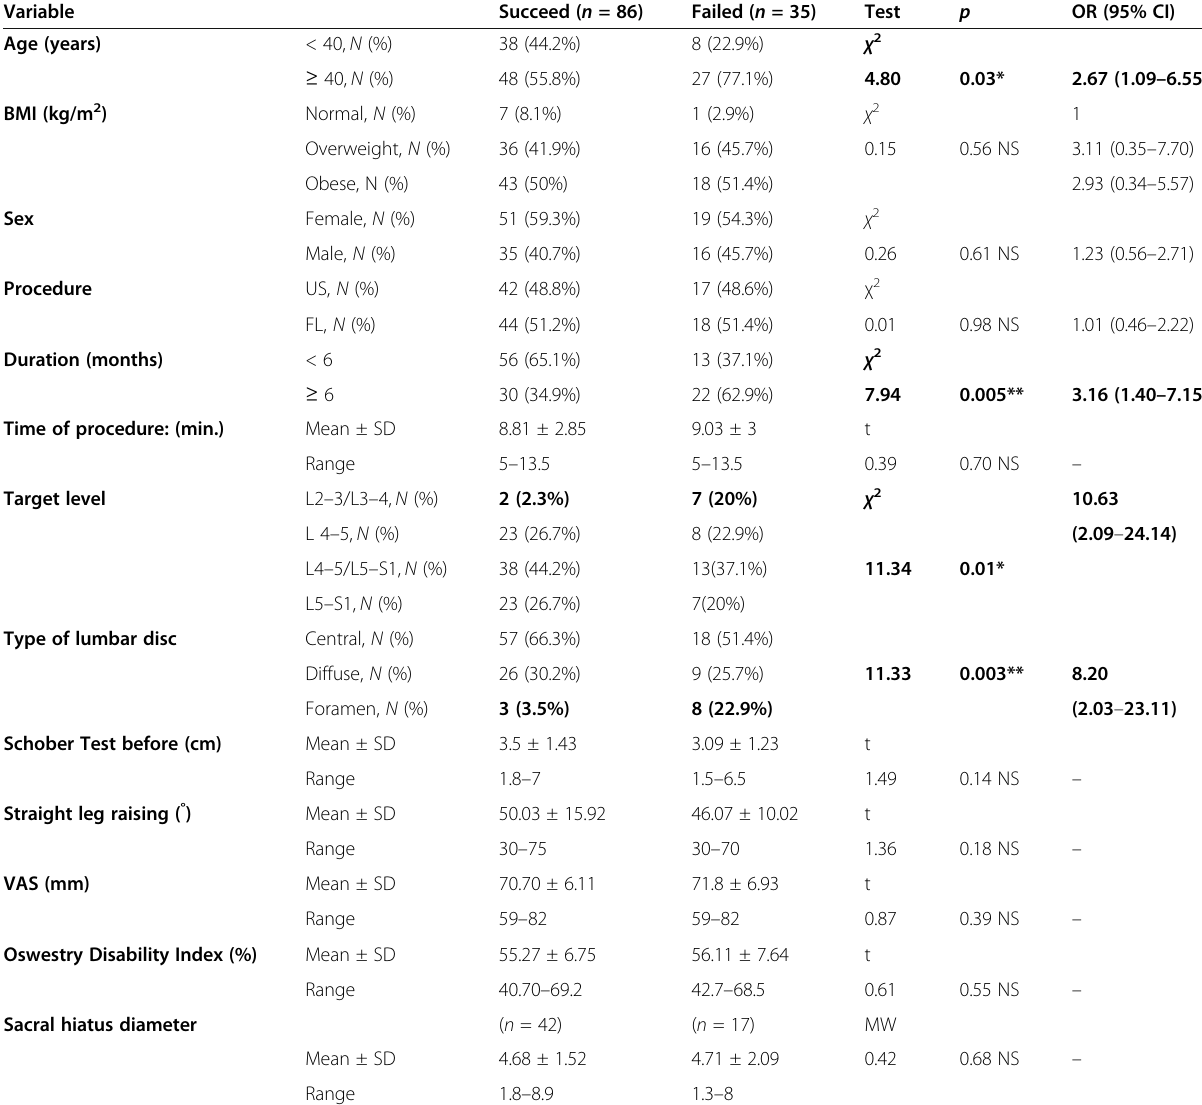
Table 6 Relation between demographic data, disease duration, time of procedure, and target level baseline data of the studied cases and outcome